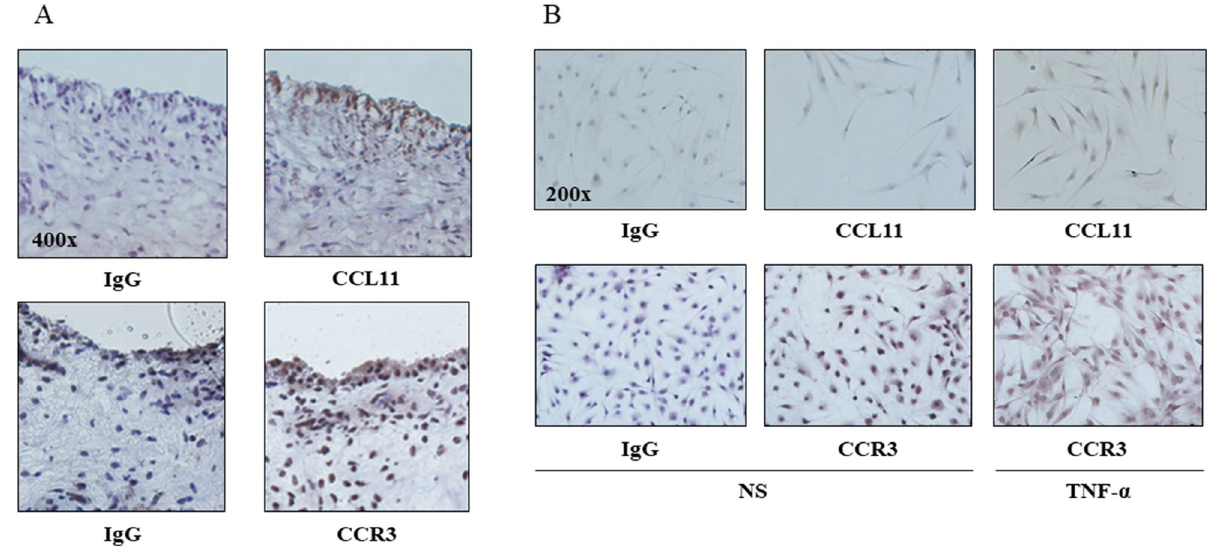
Figure 2. Immunohistochemistry showed that CCL11 and CCR3 were expressed in rheumatoid arthritis (RA) synovial tissues (STs) and fibroblast-like synoviocytes (FLS). ( A ) CCL11 and CCR3 were observed in the RA STs lining layers (magnification × 400). ( B ) CCL11 and CCR3 were expressed in RA FLS and were increased in FLS stimulated with 50 ng/mL TNF-α compared with the unstimulated FLS (magnification × 200). NS no stimulation.